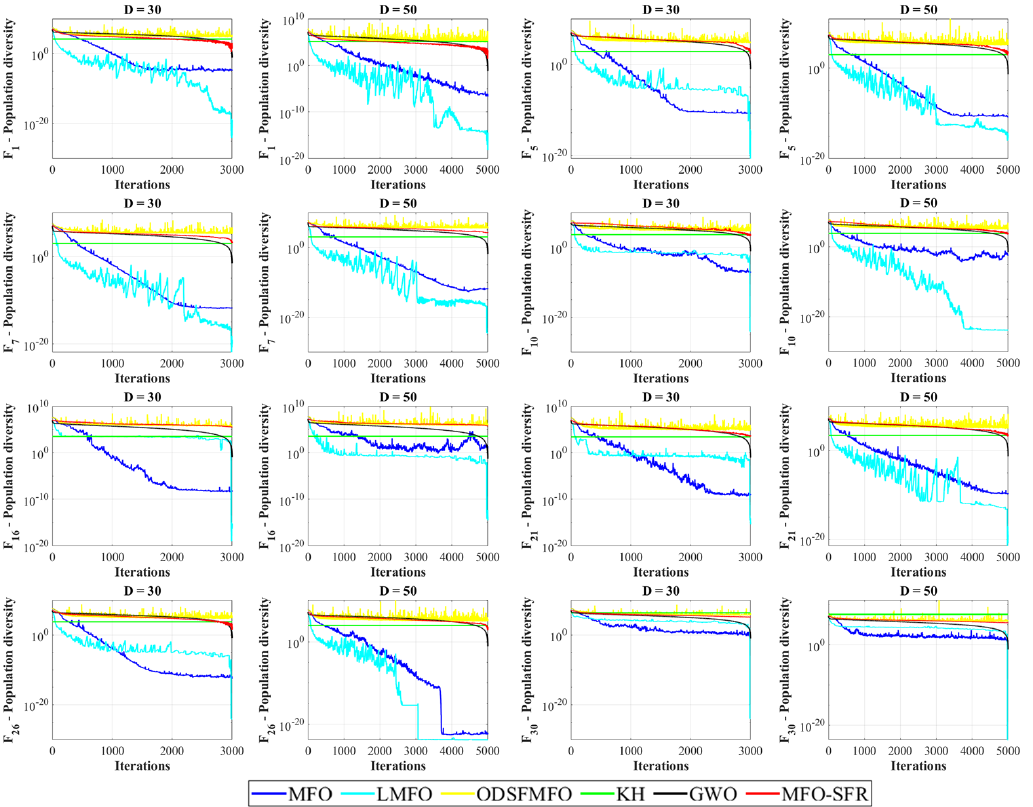
Figure 5. Population diversity of MFO-SFR and comparative algorithms on CEC 2018 test functions.